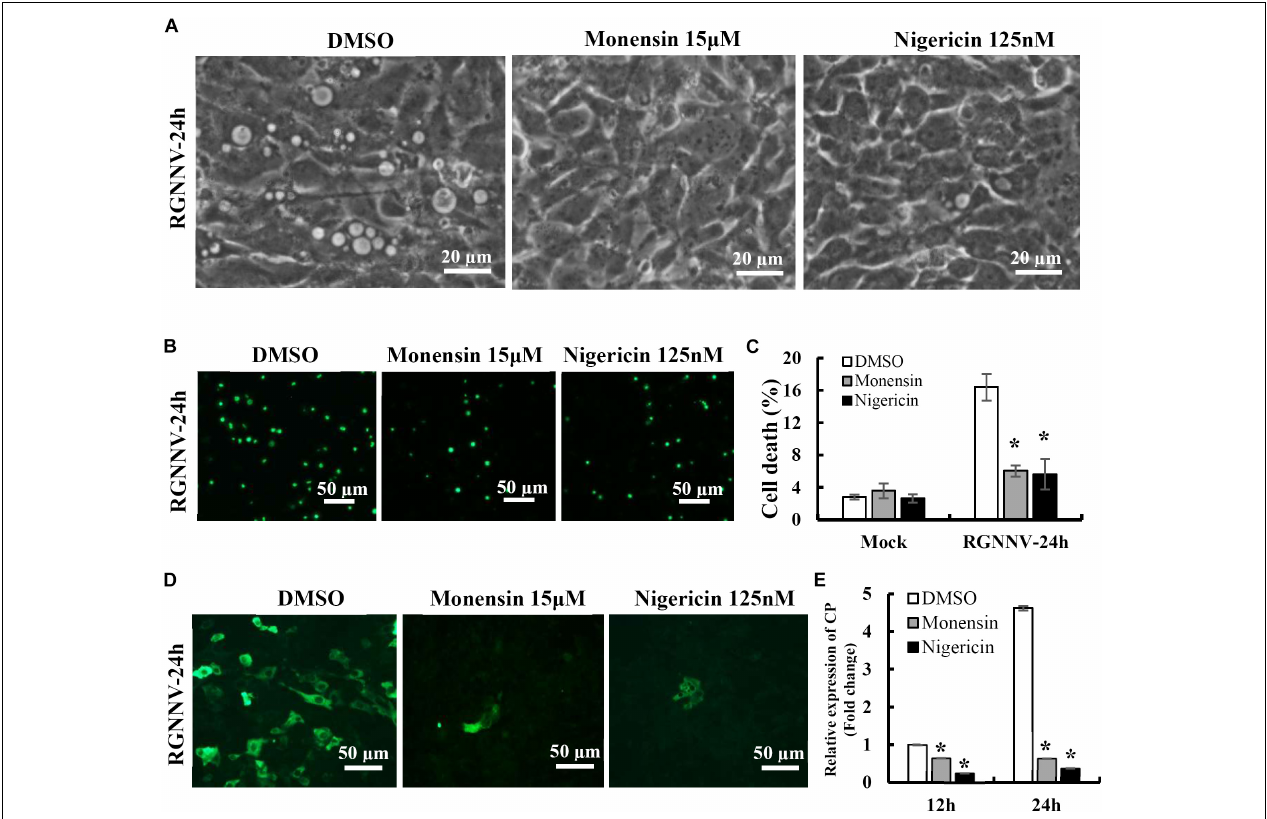
FIGURE 6 | The Na+ and K+ ionophore exerted a vital role on vacuole formation. (A) The effects of nigericin and monensin treatment on vacuole formation during RGNNV infection. (B) The effect of nigericin and monensin on RGNNV infection-induced cell death. (C) The percentage of cell death in RGNNV-infected cells following treatment with nigericin and monensin. (D) Nigericin and monensin treatment significantly inhibited viral protein synthesis. (E) Quantitative analysis of the viral transcription of RGNNV